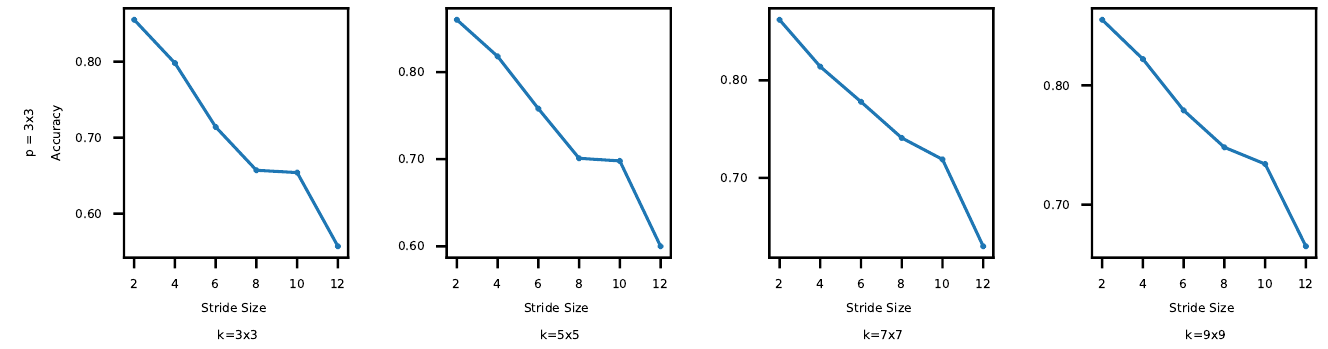
Figure 10. Stide Size vs. Accuracy (CIFAR-10). A bigger stride often results in lower